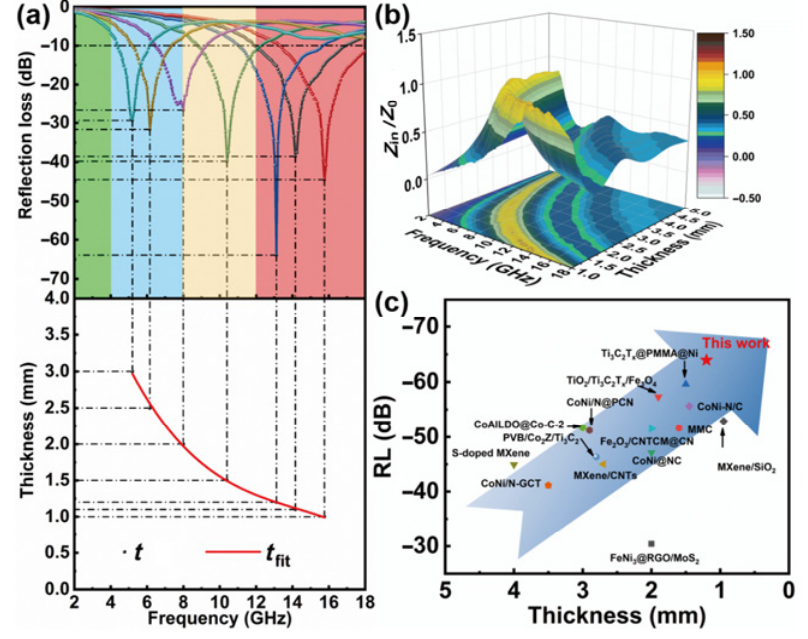
Fig. 7 (a) MA properties and corresponding thickness simulation and (b) Z in / Z 0 of SiO 2 @Ti 3 C 2 T x @CoNi ( T CoNi = 250 nm). (c) RL comparison with reported MXene-based or magnetic